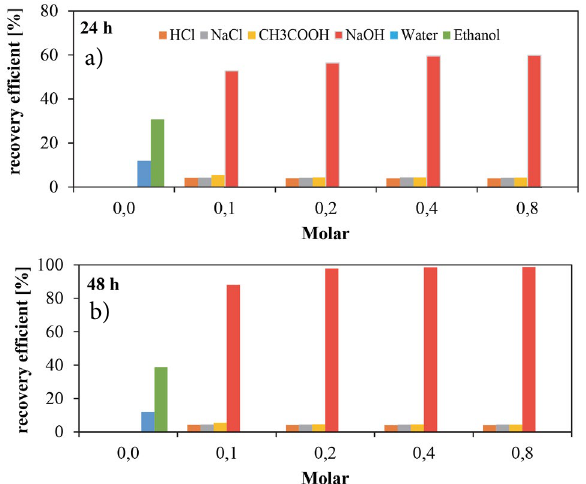
Fig. 14. Desorption of AV 17 dye from the adsorbent using different eluting agents a) 24 h b) 48 h.